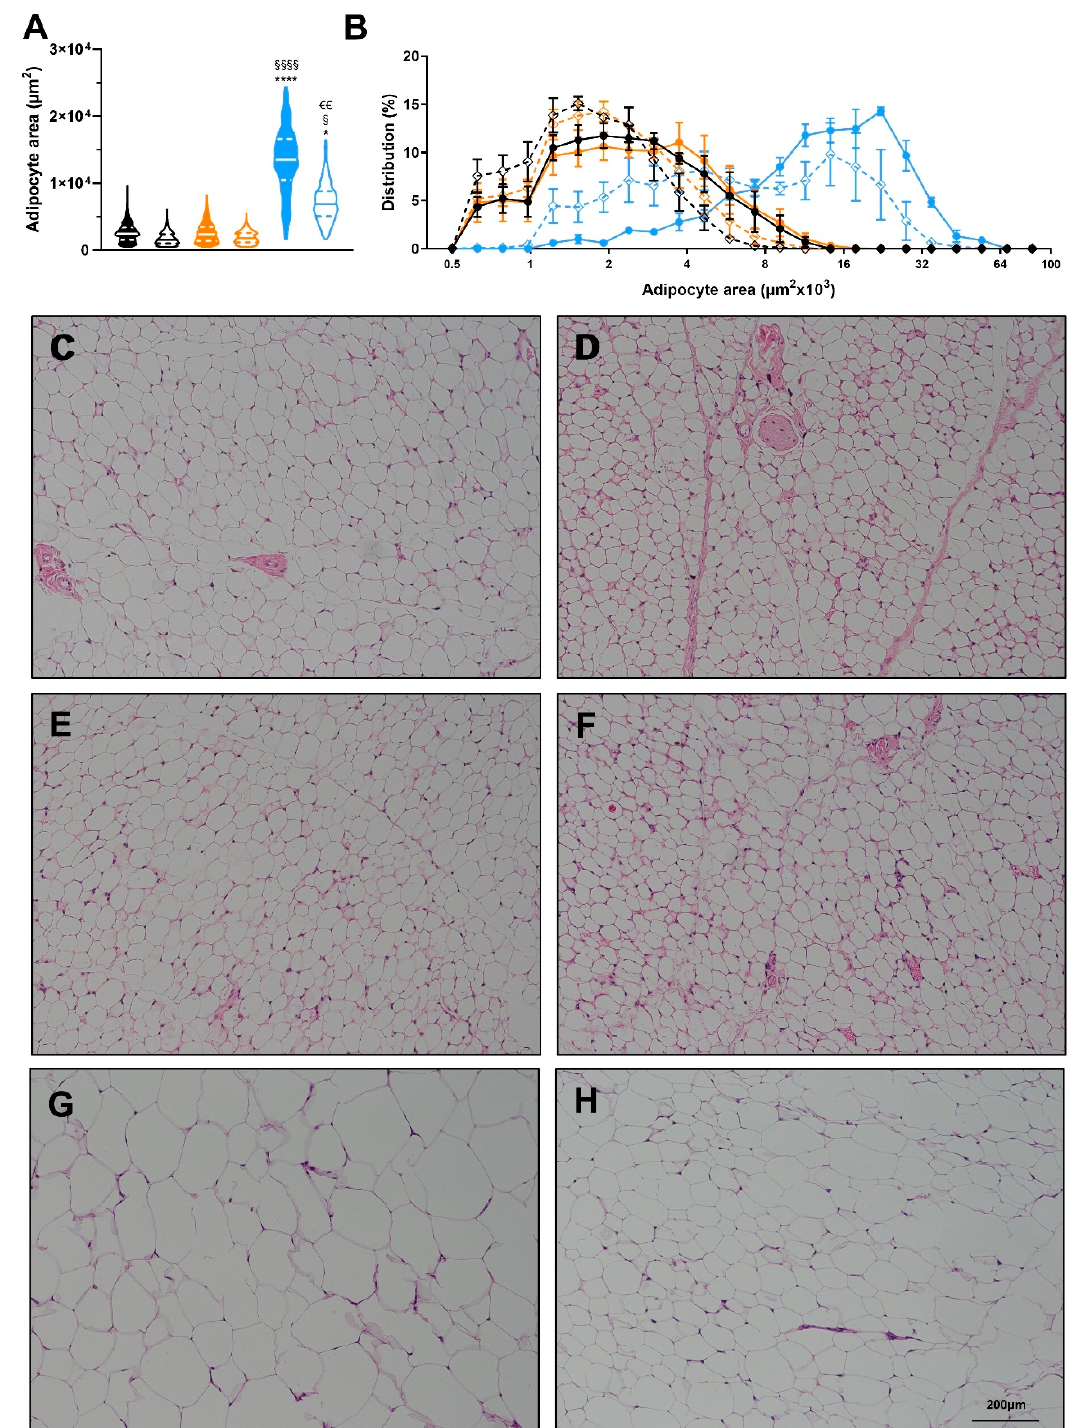
Figure 5. Effects of diet and exercise on adipocyte size. ( A ) Average adipocyte area of scWAT, ( B ) Frequency distribution of adipocyte area of scWAT. Representative histology images for ( C ) LFPD-Sed, ( D ) LFPD-Ex, ( E ) HPD-Sed, ( F ) HPD-Ex, ( G ) HFD-Sed and ( H ) HFD-Ex. N = 3–4 per group). Nested one-way ANOVA was used with Tukey’s multiple comparison test in ( A ). One or two-way ANOVA were used with Tukey’s multiple comparison test in ( B ). (* p < 0.05, **** p < 0.0001 LFPD vs. HFD, § p < 0.05, §§§§ p < 0.0001 HPD vs. HFD, €€ p < 0.01 Sedentary vs. Exercise). Data are expressed as the mean ± SEM. Violin plot is shown as min to max with median and first and third quartiles.